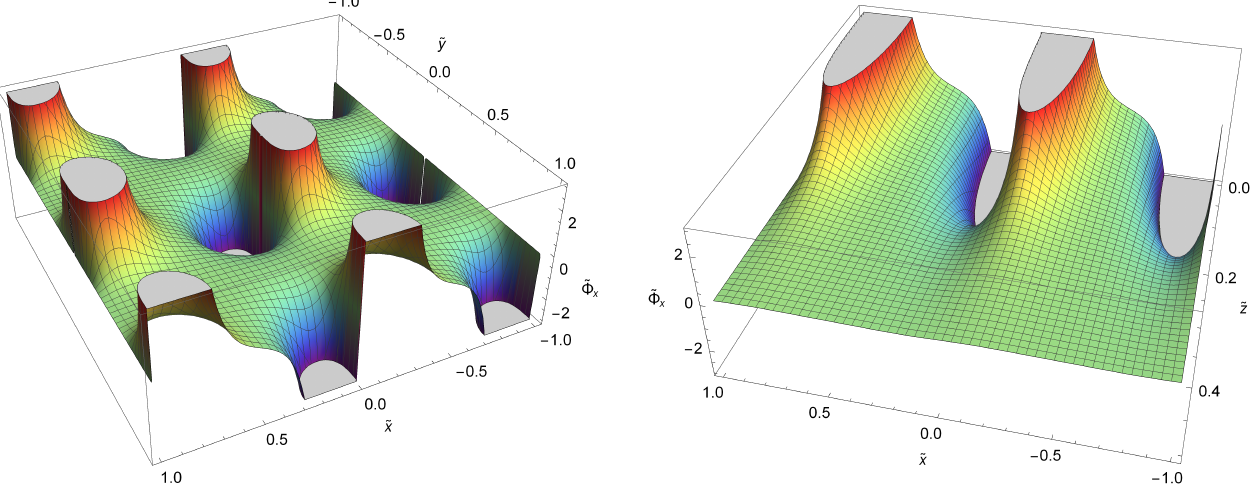
Figure 6. x -component of the rescaled force ˜ Φ x for ˜ λ eff = 0.1 for the sections z = 0 (left panel) and y = 0 (right